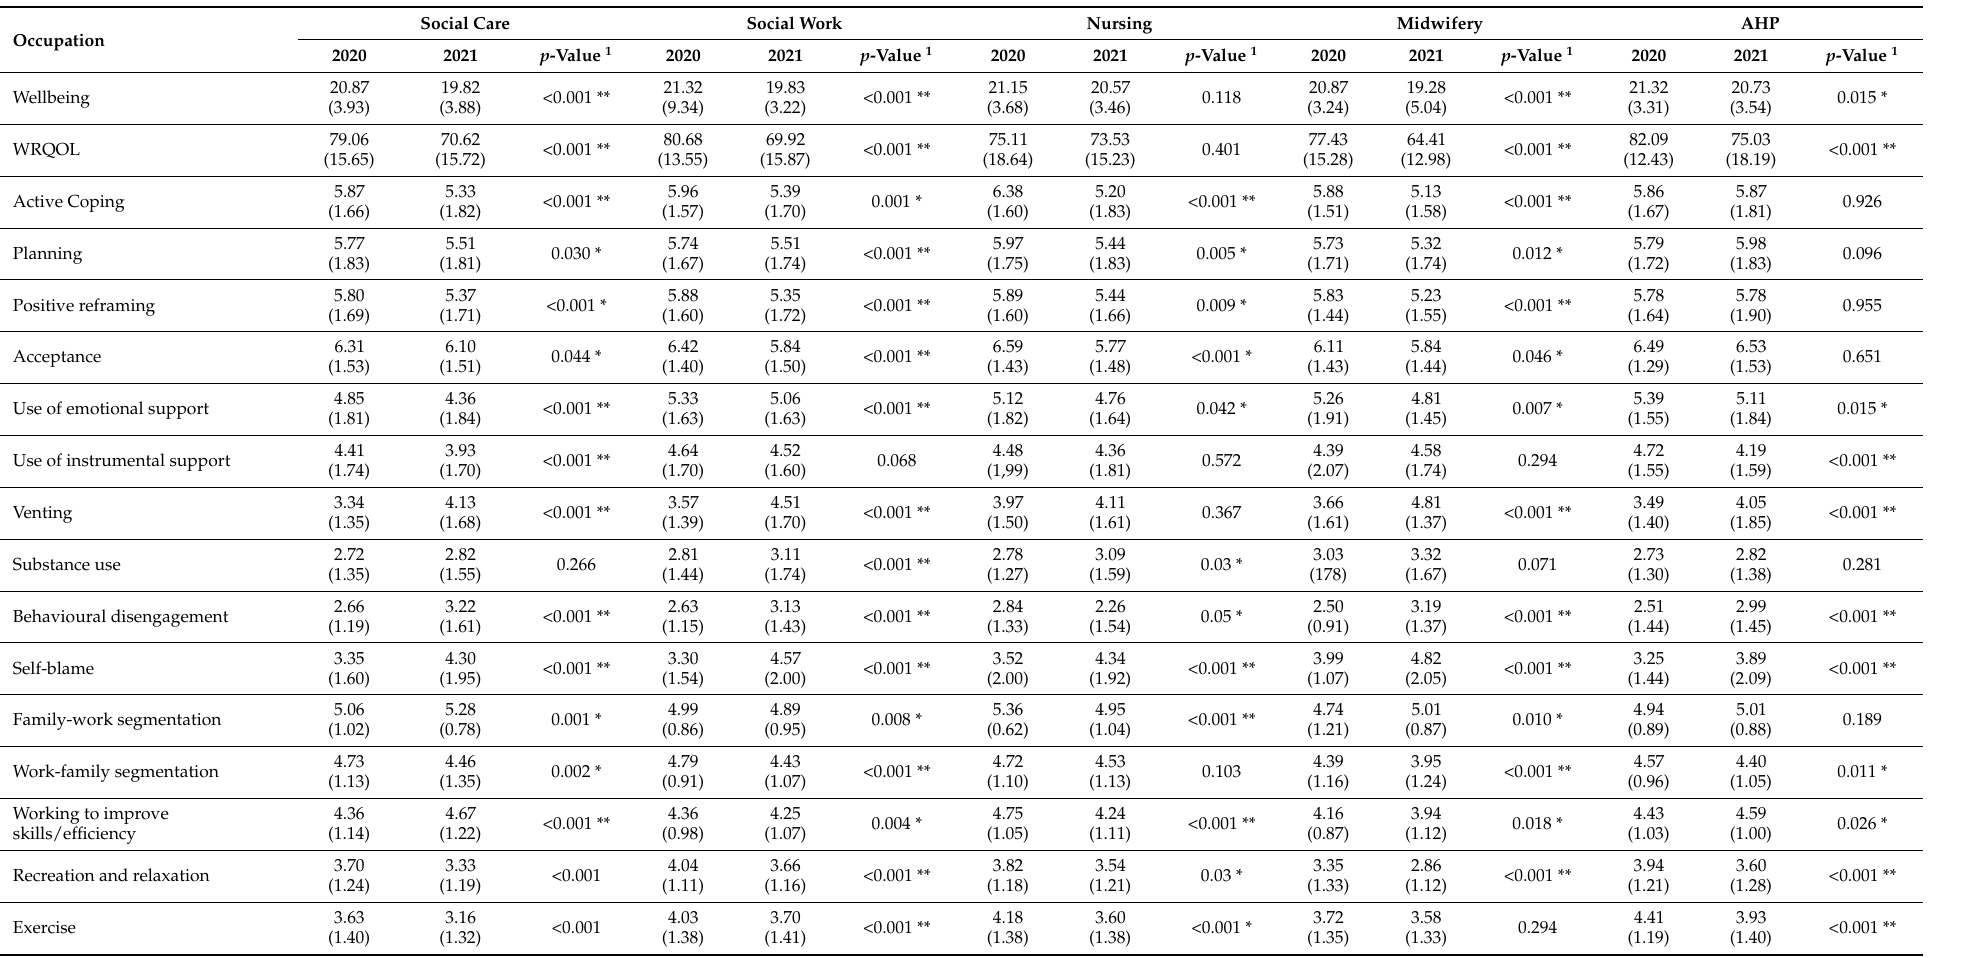
Table 3. Means and standard deviations (in brackets) for the Wellbeing, Work-Related Quality of Life (WRQoL) and Coping by occupation and across